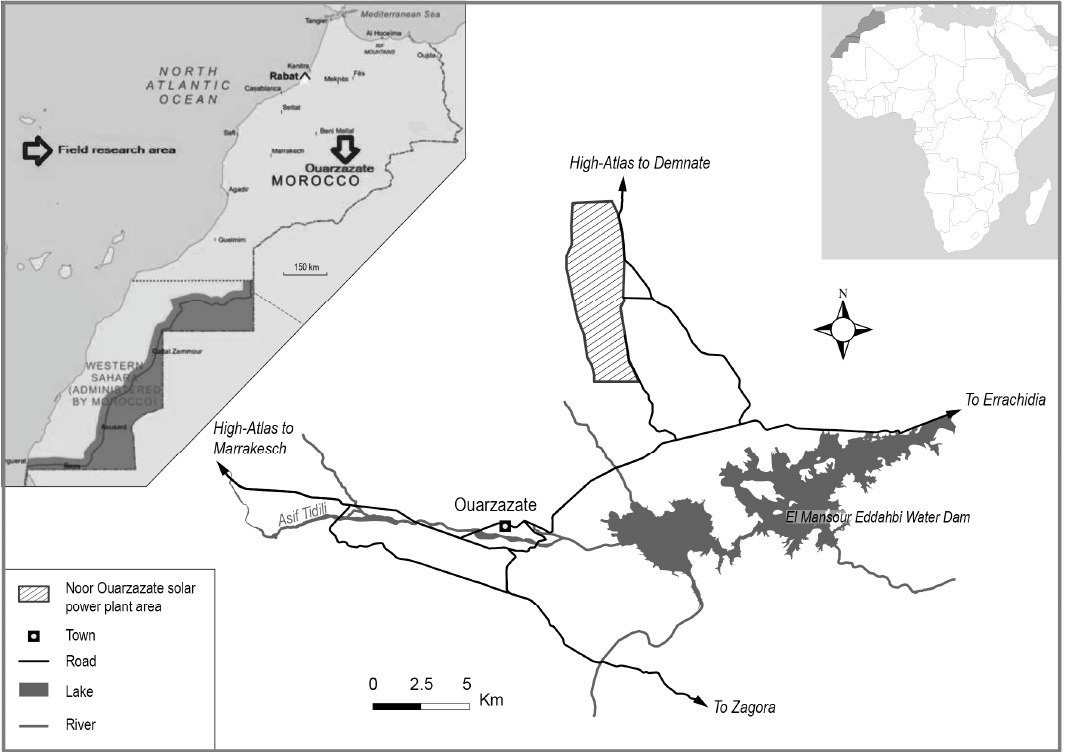
Figure 1. Location and map of the wider case study area. Map compilation and design: Gämperli Krauer Ulla (2018), CDE, Centre for Development and Environment, University of Bern, Switzerland. Geodata source: OSM data by OSMaxx (2018). Geometalab, HSR University of Applied Sciences Rapperswil, Switzerland, and Ryser, Sarah [2], Institute of Social Anthropology, University of Bern, Bern, Switzerland (Parts of the map were used for previous publications).